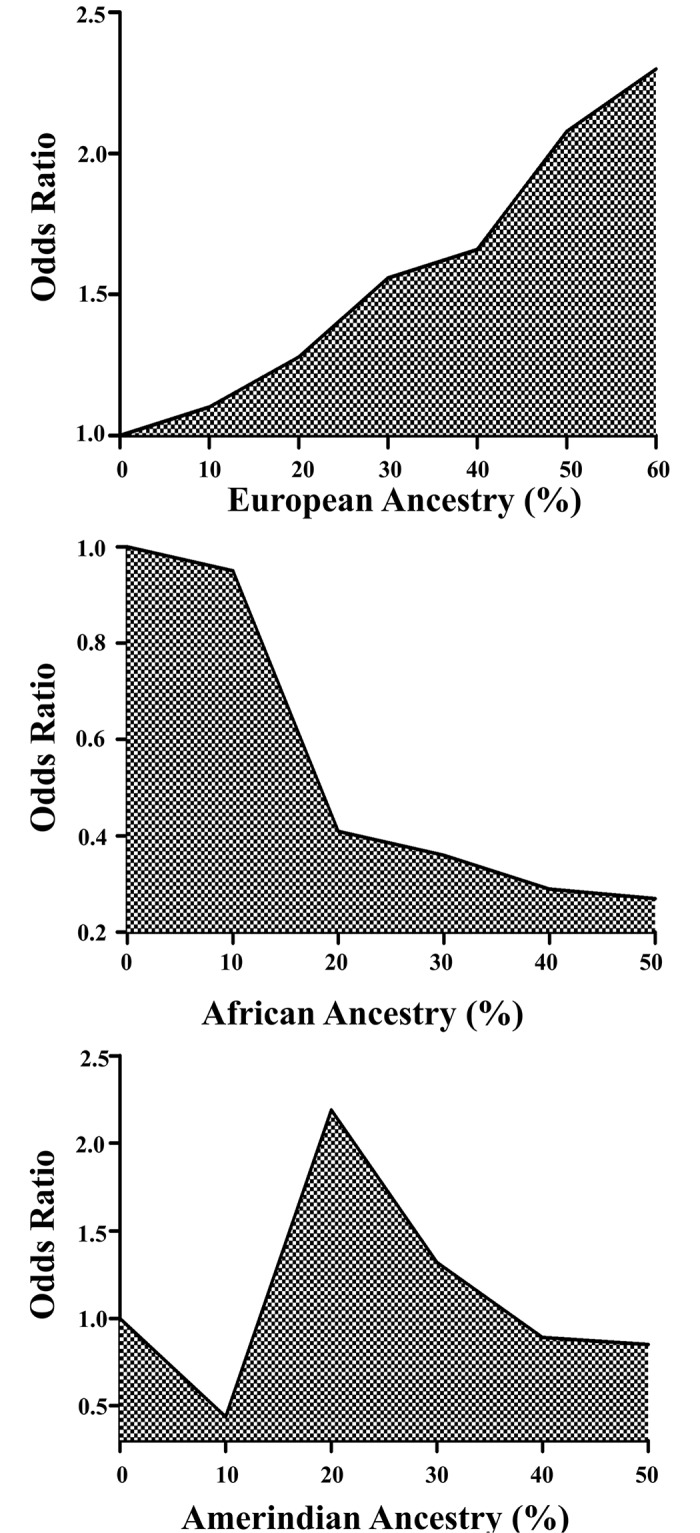
In a comparison of 141 leprosy patients and 180 healthy individuals, events with statistically significant (p<0.05) differences can be categorized into six categories of individuals with African and European genetic ancestry (10%>20%> 30%>40%>50%>60%), the p-values were adjusted by age and gender.The analysis in individuals with Amerindian ancestry was not statistically significant.